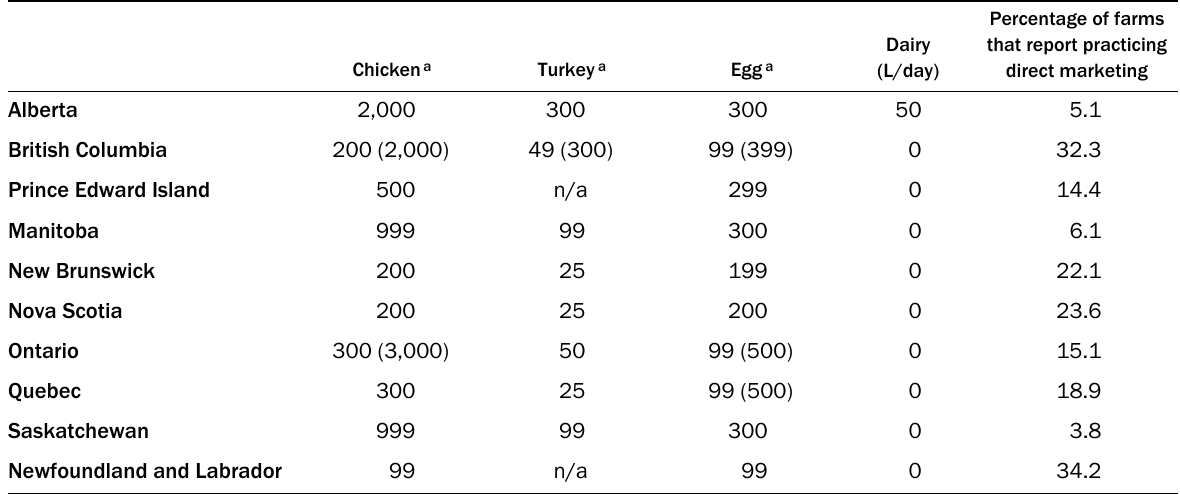
Table 1. Quota Exemption Limits and Percentage of Farms that Practice Direct